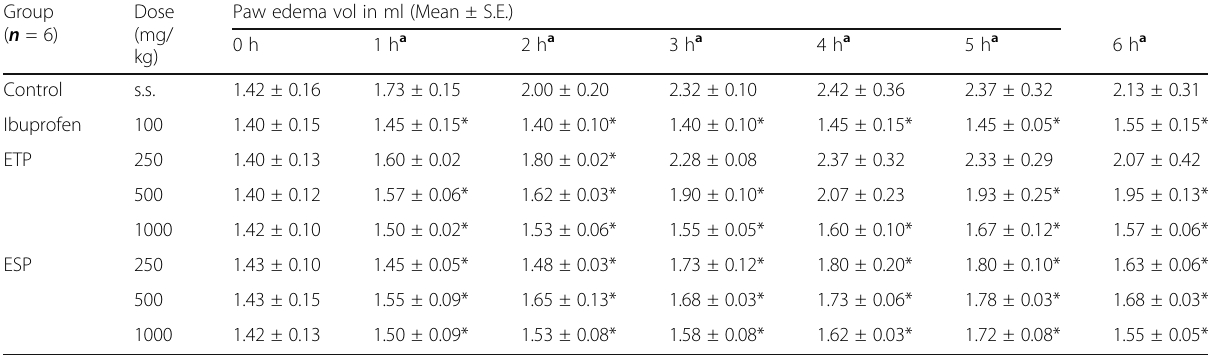
Table 1 Effect of ethanol extracts of propolis of T. fiebrigi (ETP) and S. jujuyensis (ESP) on edema carrageenan-induced rat paw edema Group Dose ( n = 6)